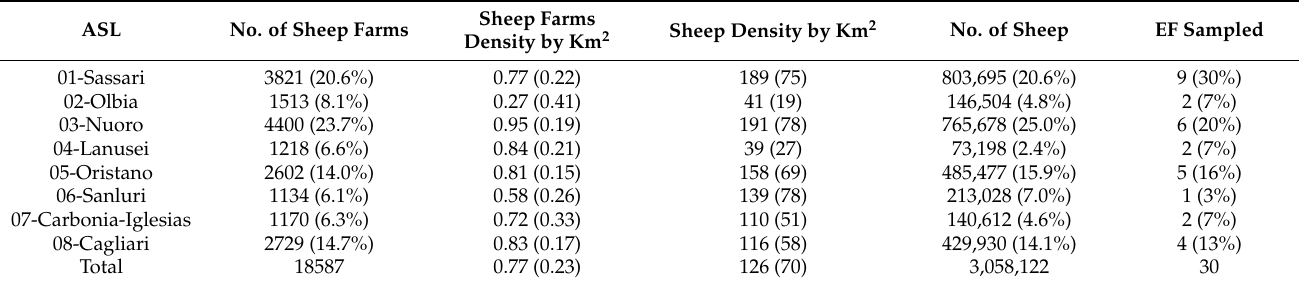
Table 3. Analysis of territorial context for each ASL: sheep farms per Km 2 , sheep per Km 2 , total number of sheep. Data are presented as number (percentage, %) or mean and standard deviation (SD), calculated by municipalities included in each